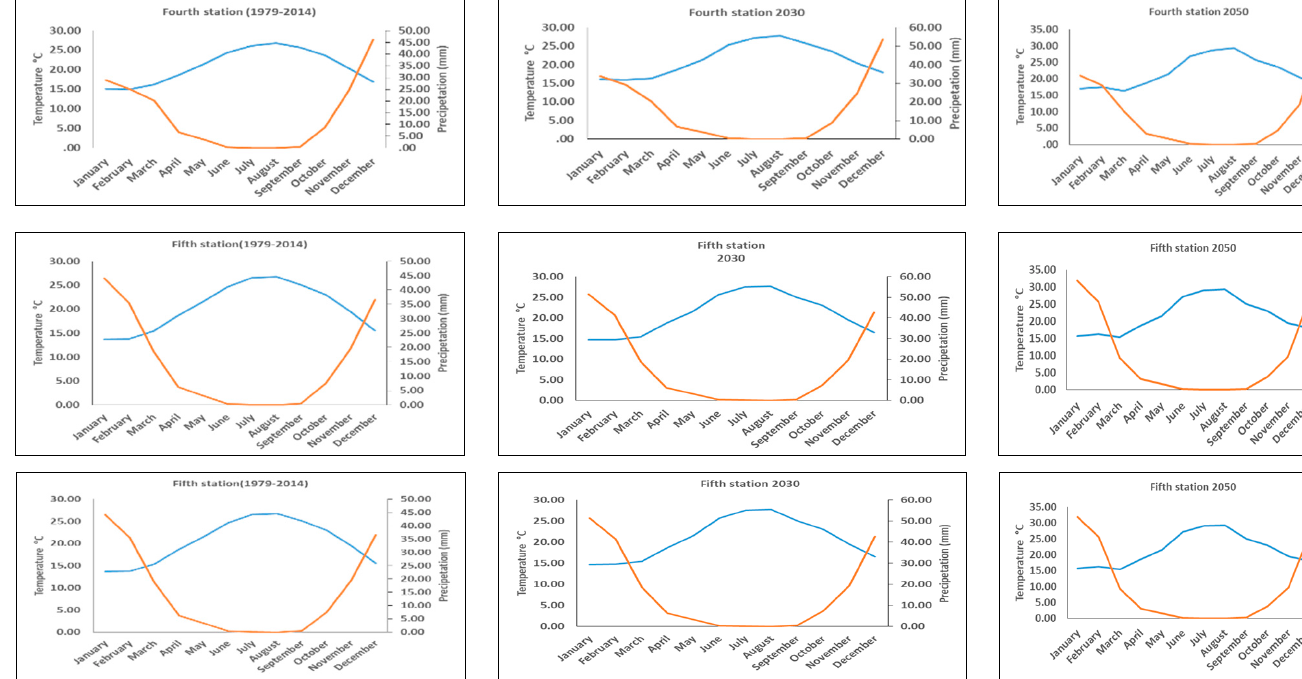
Figure 14. Climate change data.